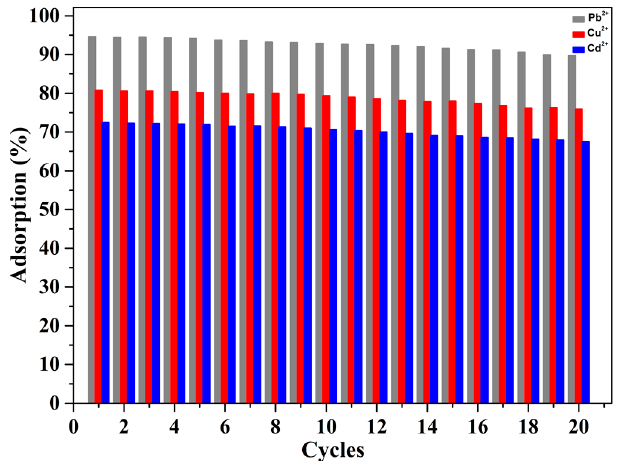
Figure 11. Regeneration research of mp-CA/GO. (~ 50 mg of mp-CA/GO and 1.5 mM of Pb 2+ solution were used here).